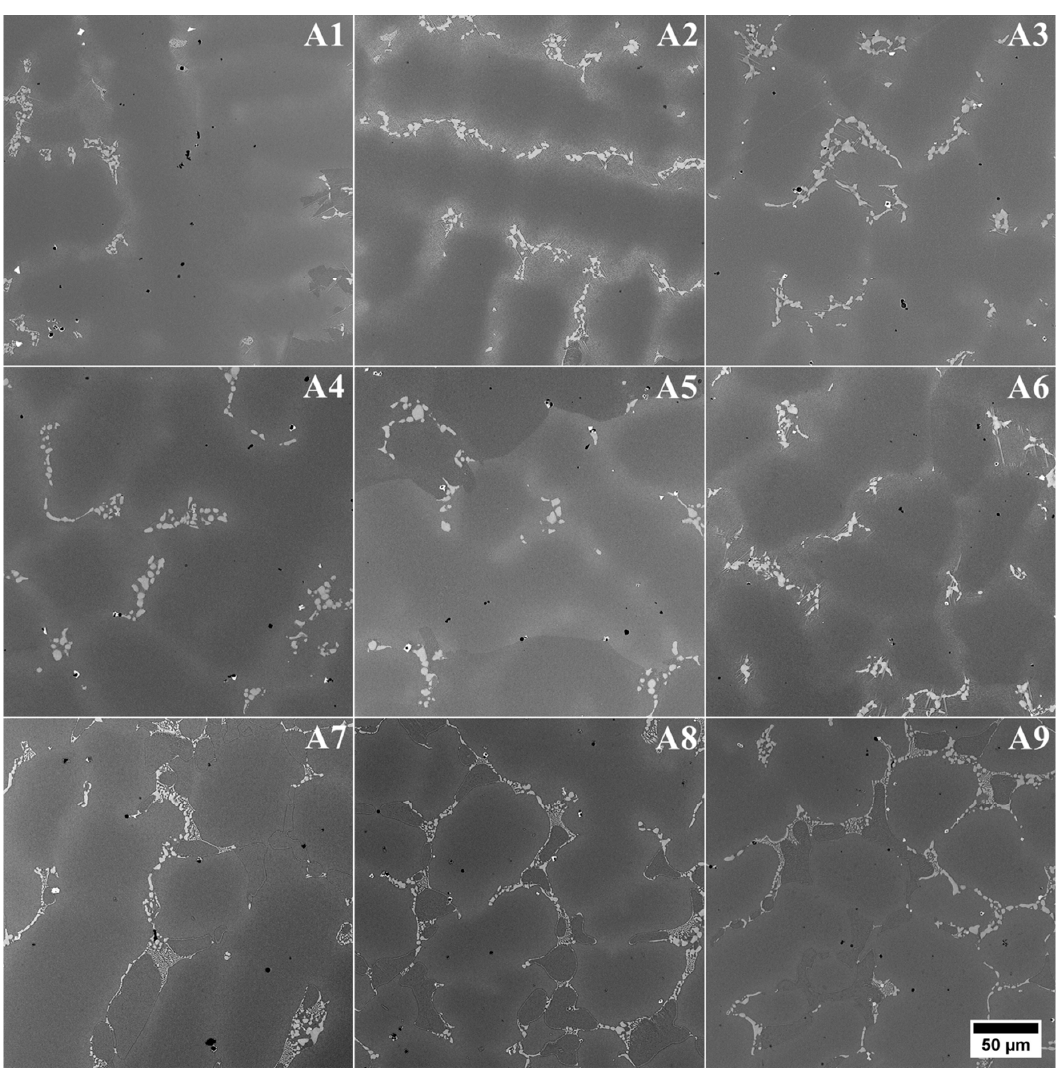
Figure 9. The dendritic structure of the modified alloys.